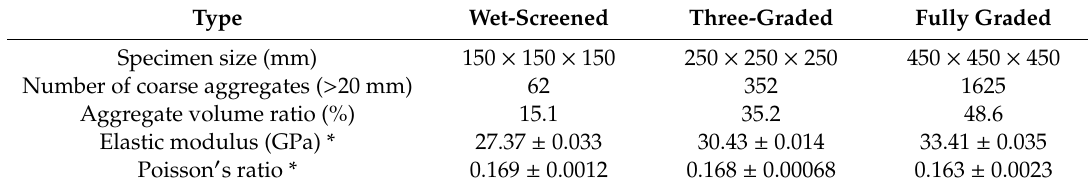
Table5. Comparisonofcalculatedelasticconstantsofconcretesamplesofdi ff